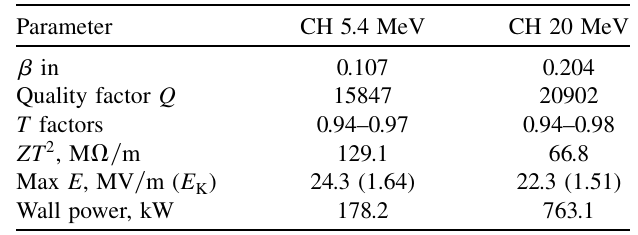
TABLE VII. Parameters of LANSCE DTL tanks 1–3.